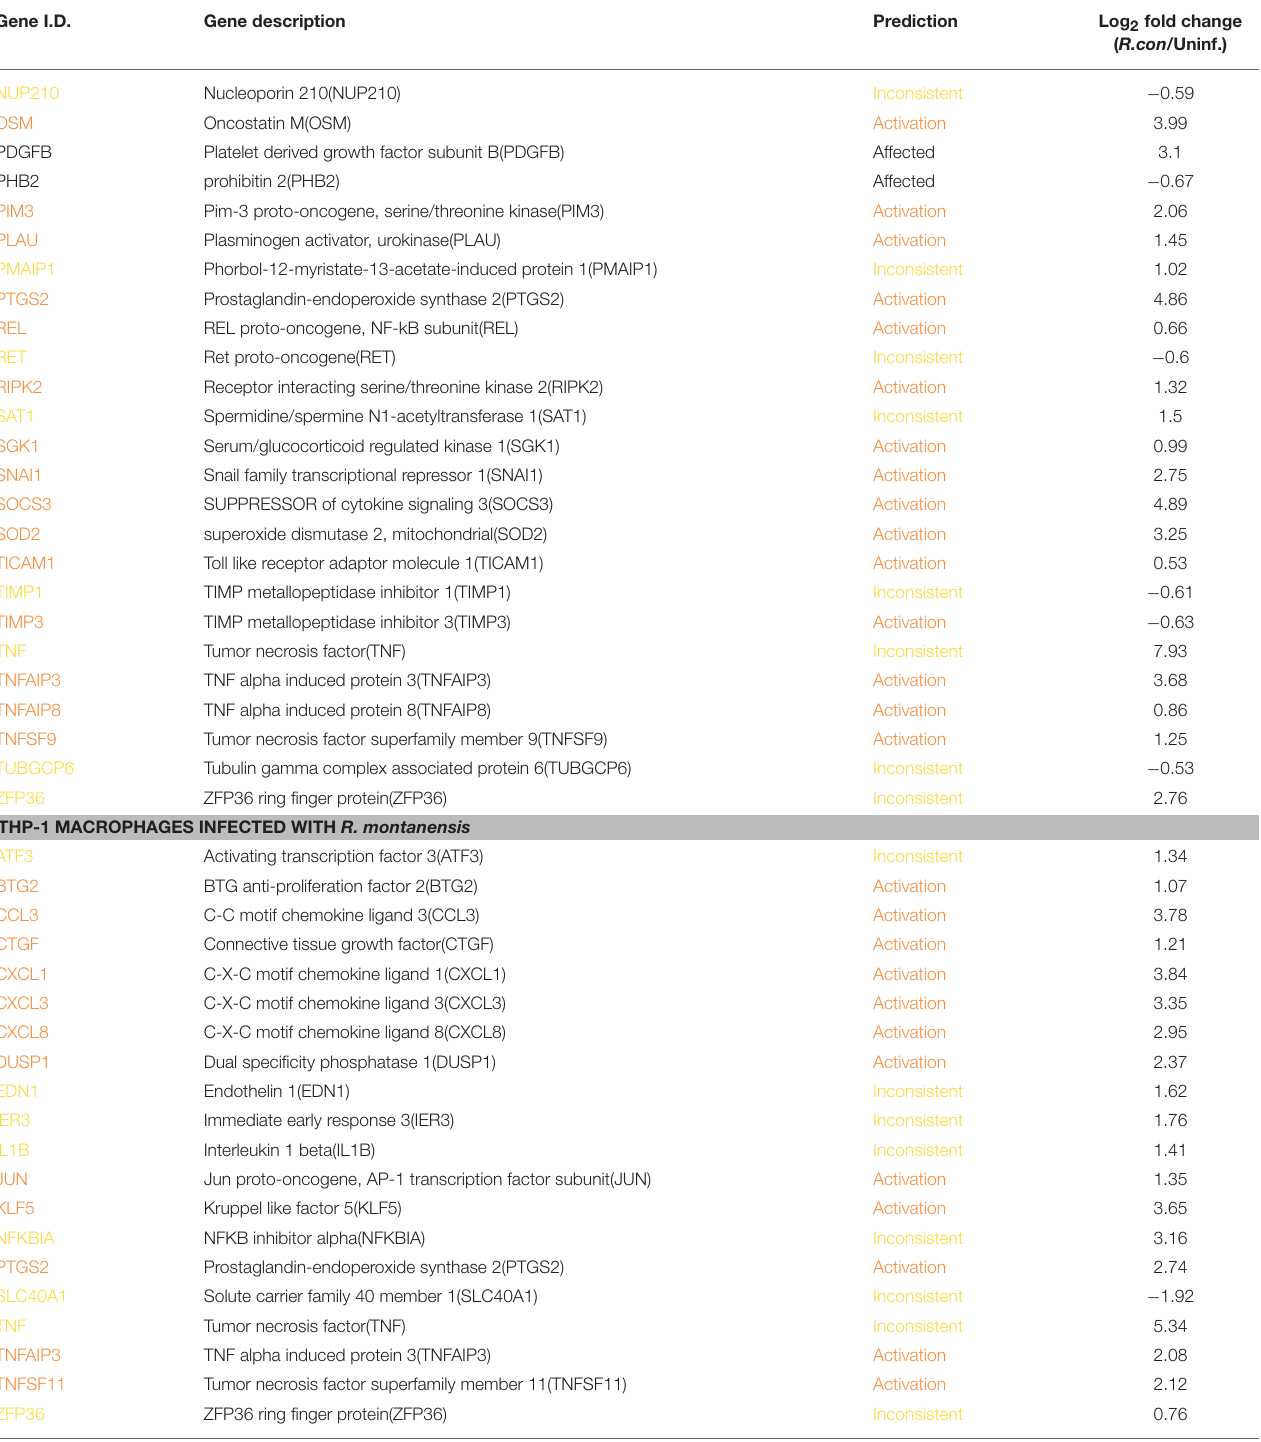
Frontiers in Cellular and Infection Microbiology |